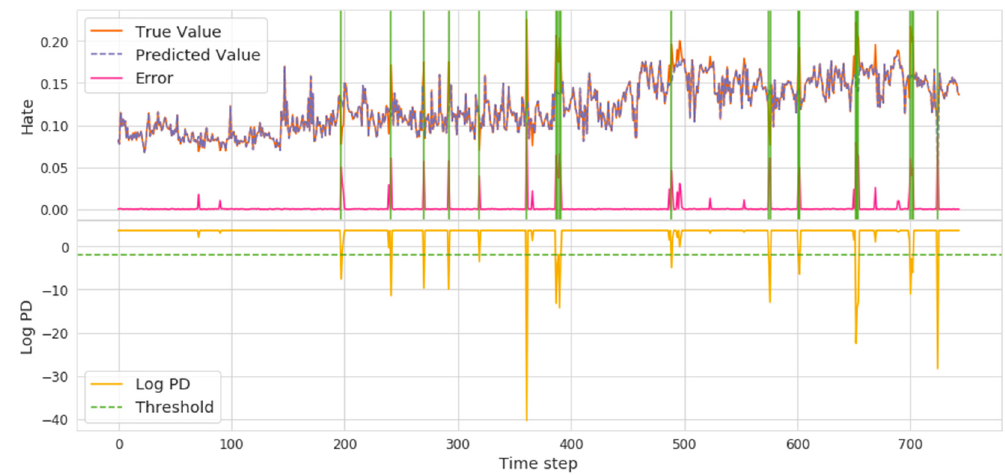
Figure 7. Hate Volatility and Abrupt Time Points.